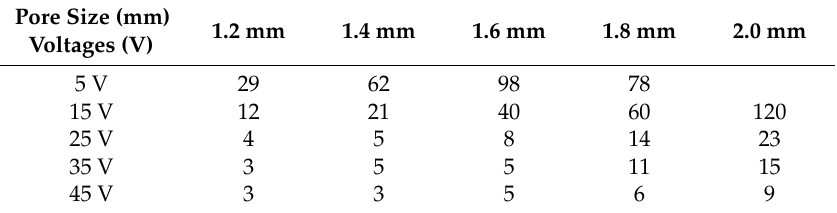
Table 2. List of focal length for different pore sizes under different voltages (unit: